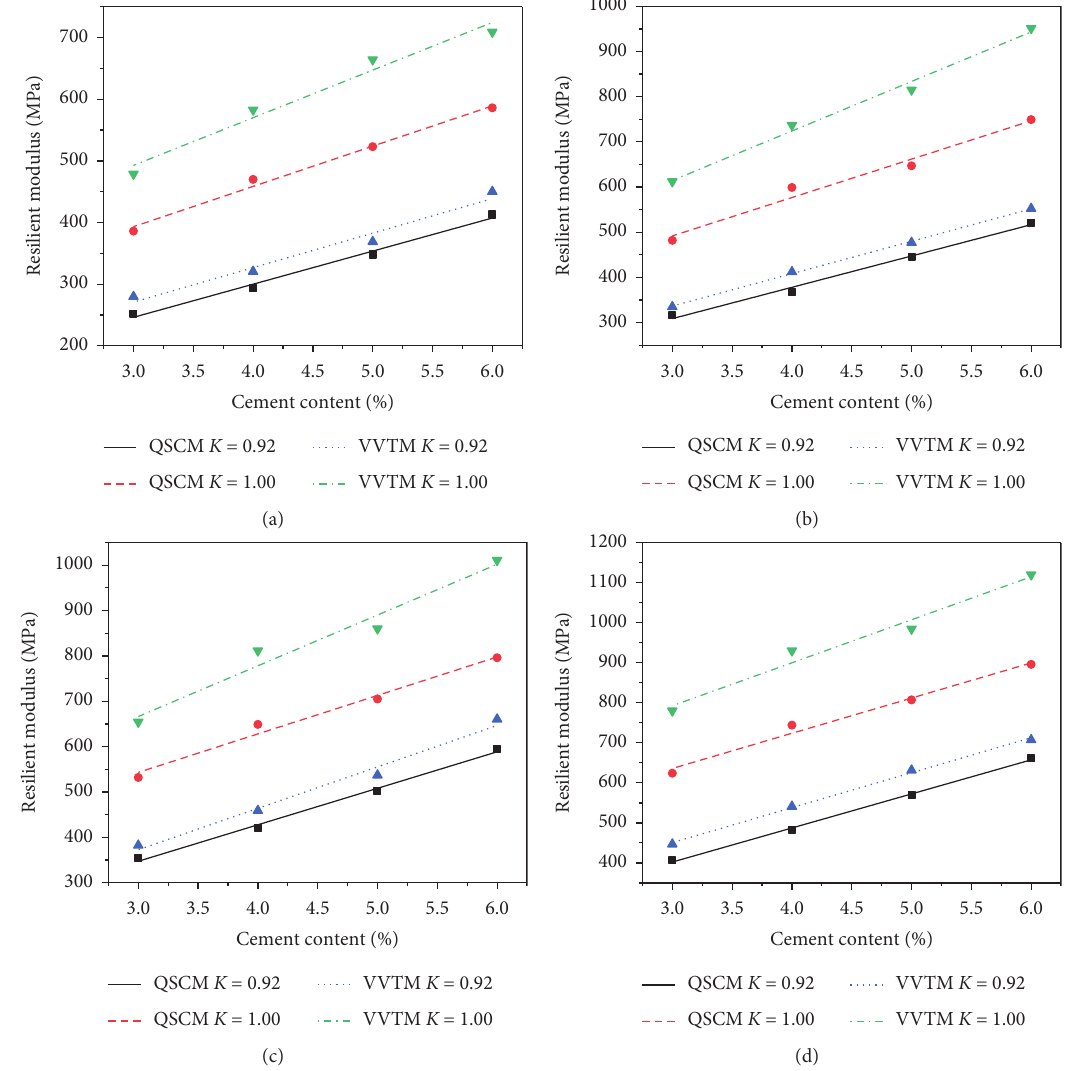
Figure 10: Influence of cement content on RM of CSL compacted using VVCM and QSCM. (a) 7d. (b) 14d. (c) 28d. (d)